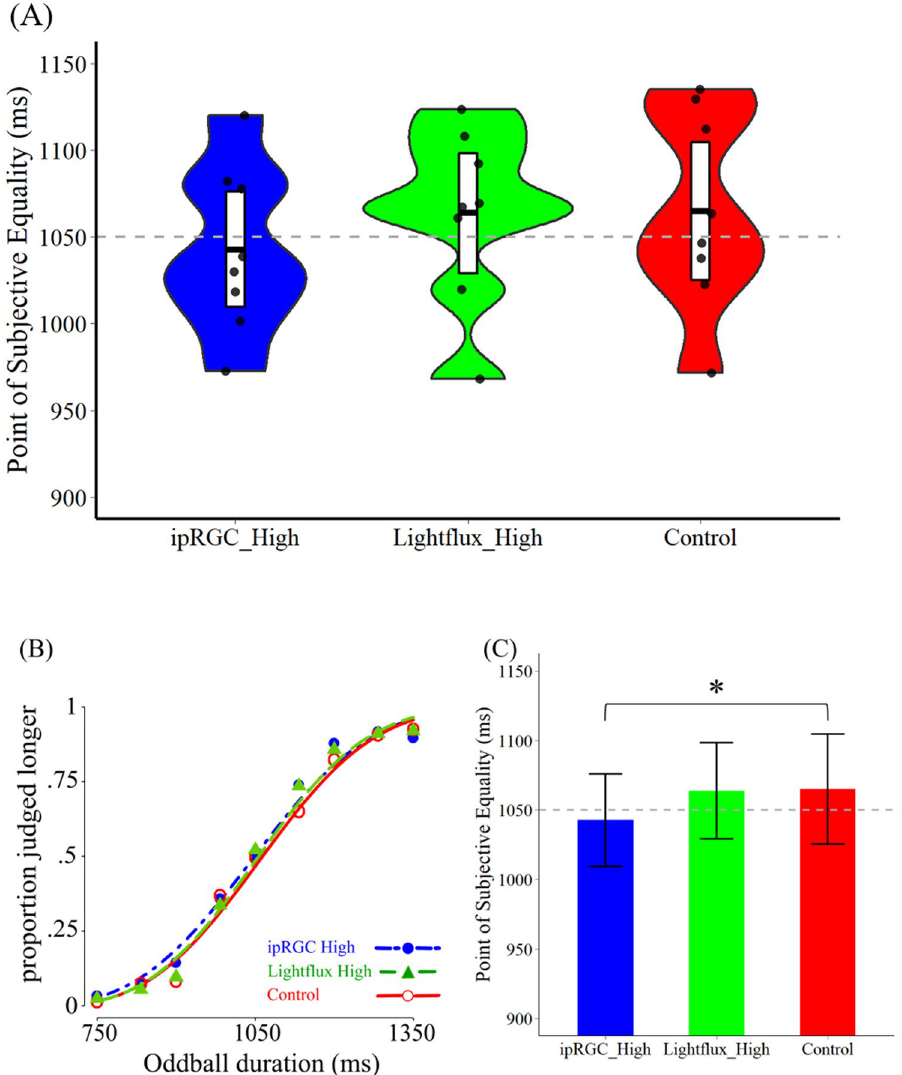
Figure 5. The results of Experiment 2. ( A ) The fitted PSE for all three conditions in Experiment 2. The white bar in the middle indicates the 95% confidence intervals of each condition and the black line is the group mean. Each dot represents one participant’s fitted PSE value. The gray dashed line in the middle shows the duration of standard stimuli. ( B ) The group-averaged psychometric function in the three conditions. ( C ) The PSE for each condition. The PSE in the ipRGC High condition was significantly lower than that in the Control condition, while no other differences were found between other pairs of